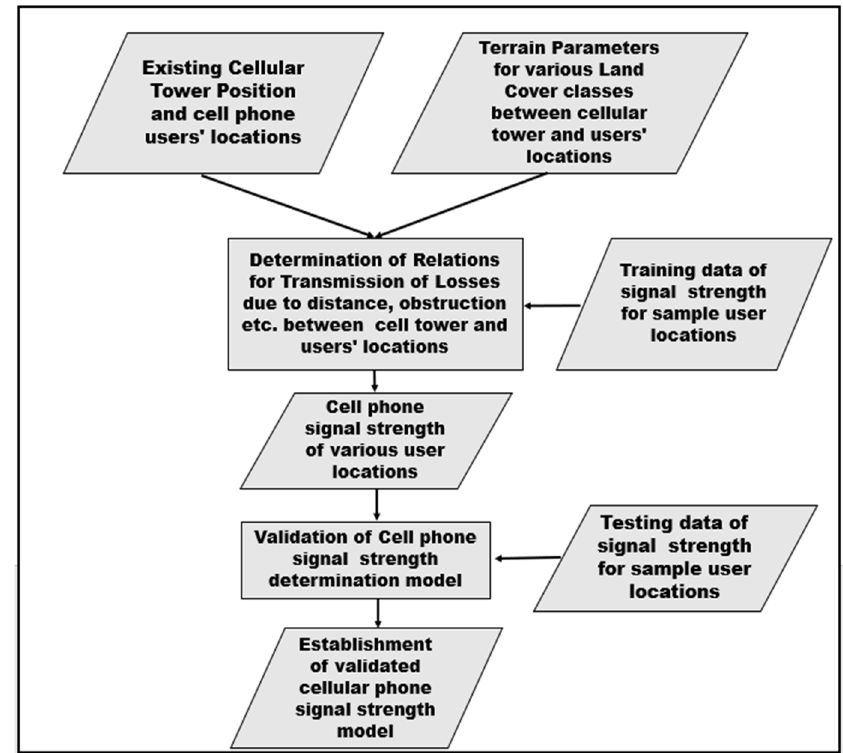
Figure 4. Cell phone signal strength determination model.